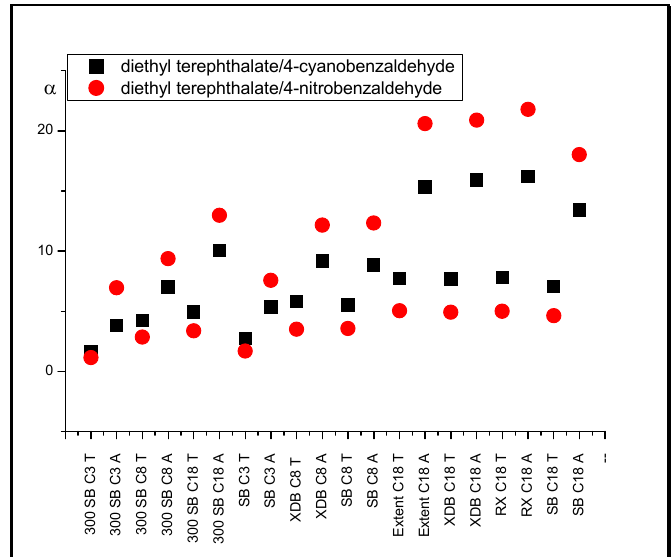
Figure 4. Separation factor, α , values of dimethyl isophthalate/4 ‐ cyanobenzaldehyde and dimethyl isophthalate/4 ‐ nitrobenzaldehyde in systems with different nonpolar stationary phases and (T) tetrahydrofuran in water, and (A) acetonitrile in water (modifier concentrations as in Table 1).